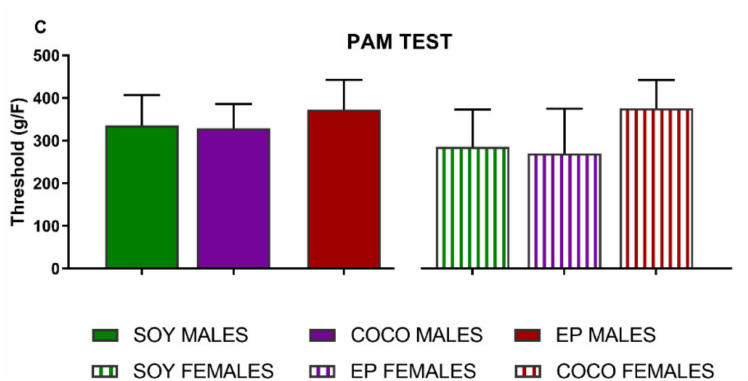
Figure 4. Effects of diet intervention on somatic sensitivity in the rat. Male and female rats were exposed to AIN-93G diet containing 7% of soybean oil (SOY), or to modified AIN-93G diet containing 3.5% of soybean oil supplemented with 3.5% of coconut oil (COCO) or with 3.5% of evening primrose oil (EP). Mechanical and thermal sensitivity were measured as the force or time necessary to elicit a nociceptive response in the von Frey ( A ), plantar test ( B ), and PAM test ( C ), analyzed in males and females separately. Data are presented as mean ± S.D. or median and I.Q.R, when not normally distributed ( n = 6–13 per group). One-way ANOVA followed by Bonferroni’s multiple comparison or Kruskal–Wallis test followed by Dunn ´ s multiple comparison test.